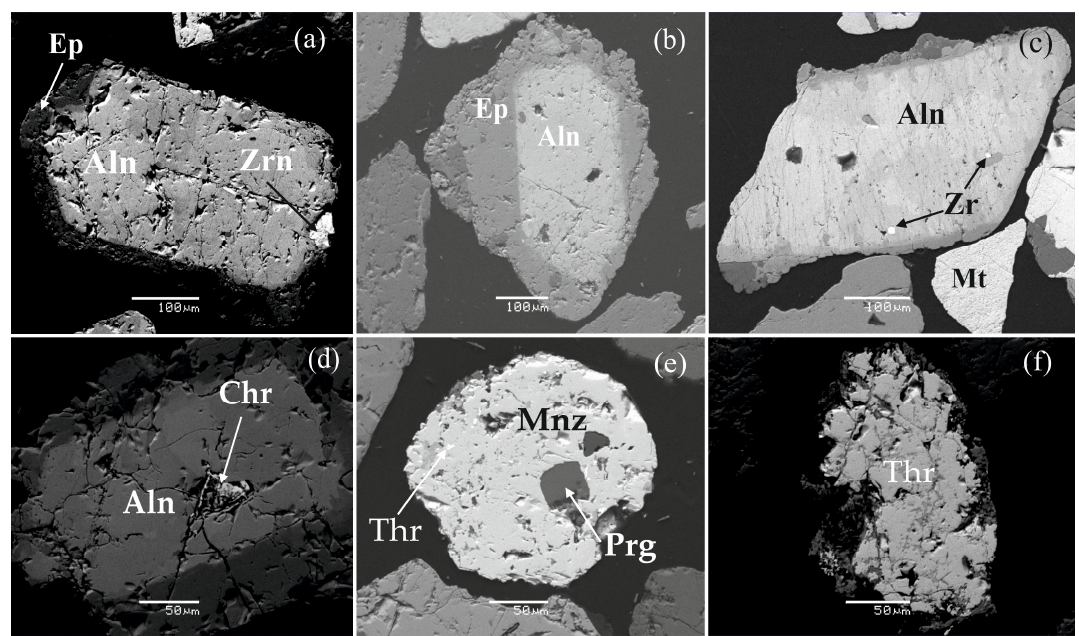
Figure 3. Backscattered electron images from SEM of various rare earth element (REE) minerals and other heavy minerals of different particle size fractions. ( a , b ) zoned allanite–(Ce) showing metamict structure and epidote peripheral zone (−0.425 mm to +0.212 mm), ( c ) allanite containing zircon inclusions from the magnetic fraction, ( d ) zoned allanite with weathering features and cracks containing inclusion of Ca-rich monazite (cheralite) ( e ) monazite containing pargasite and thorite inclusions, from the magnetic fraction, ( f ) thorite-weathered grain, darker zones are U depleted);